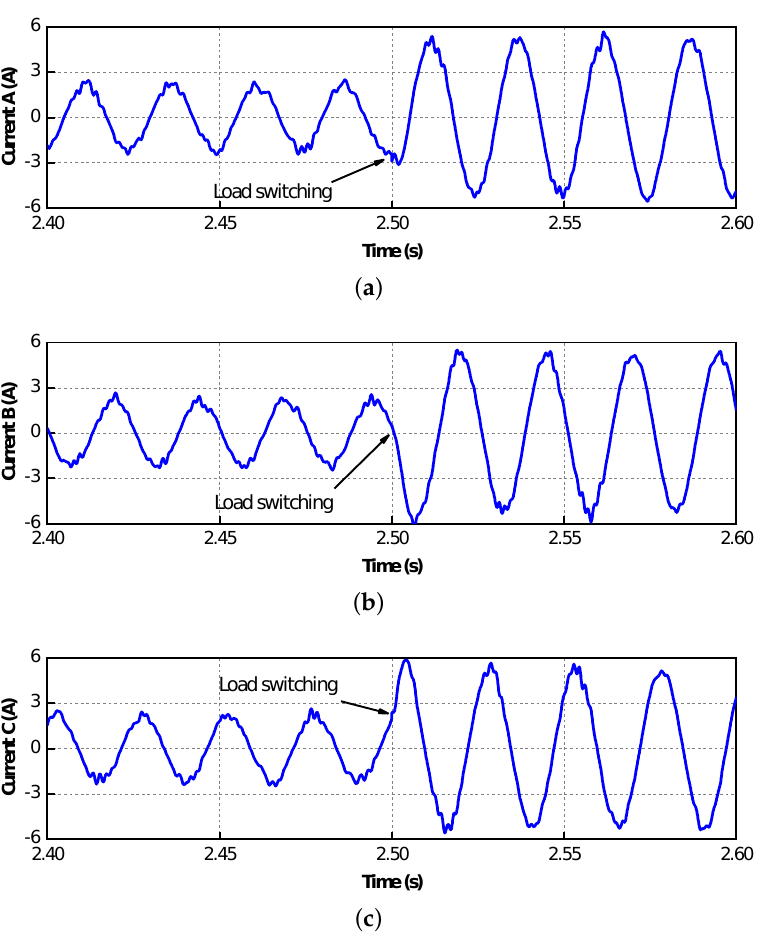
Figure 27. Experimental results.( a ) Phase A current; ( b ) Phase B current; and ( c ) Phase C current.